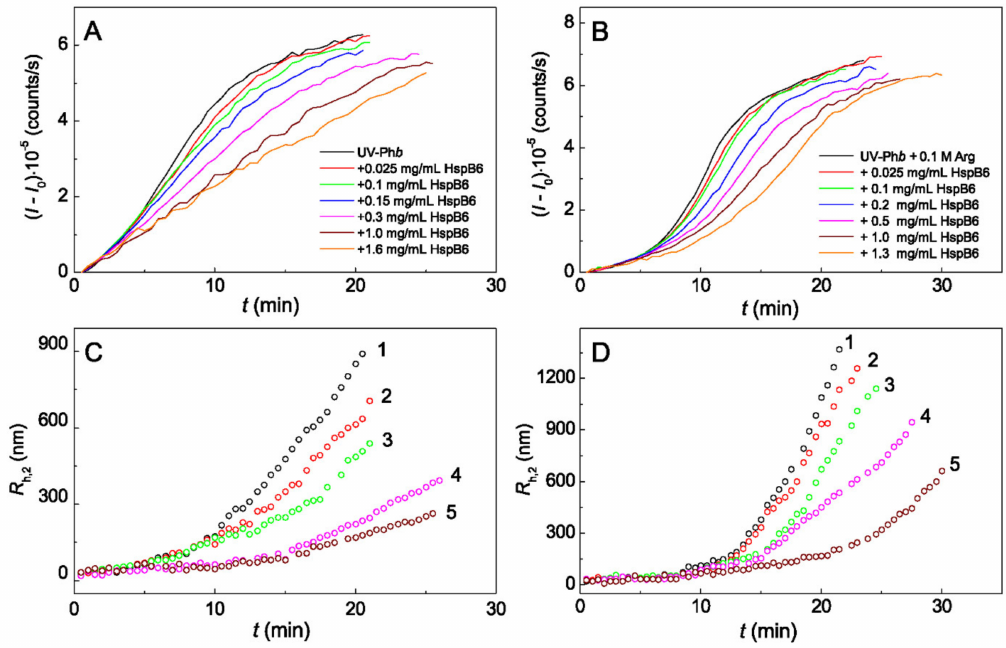
Figure 1. E ff ect of HspB6 on the kinetics of aggregation of UV-Ph b (0.25 mg / mL) in the absence ( A , C ) and in the presence of 0.1 M Arg ( B , D ) at 37 ◦ C. ( A , B ) The dependences of the light scattering intensity ( I − I 0 ) on time. The concentrations of HspB6 are shown in panels ( A , B ). ( C , D ) The dependences of the hydrodynamic radius R h,2 of protein aggregates on time obtained at the following concentrations of HspB6: (1) 0, (2) 0.025, (3) 0.1, (4) 0.3 and (5) 1 mg /